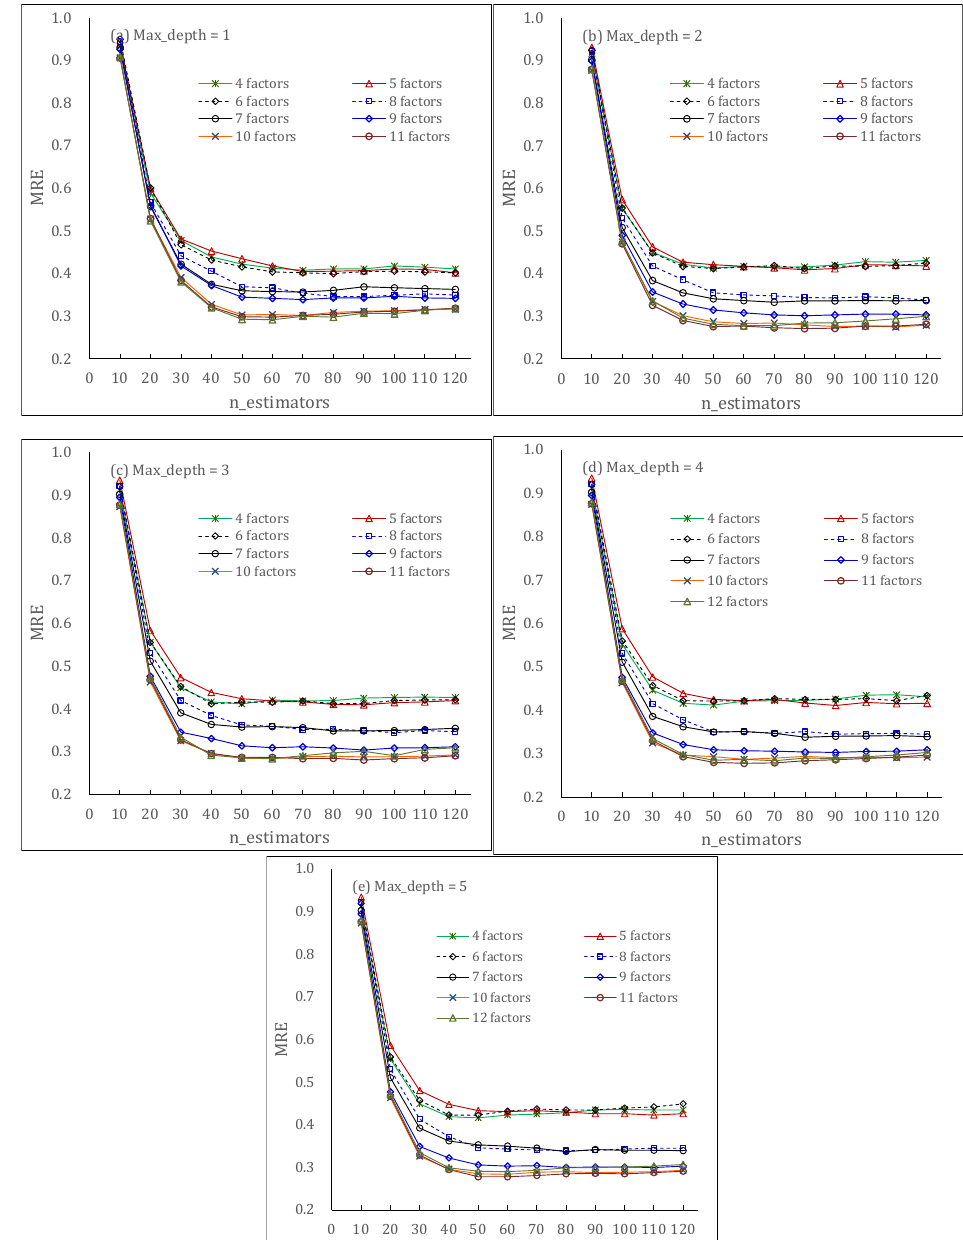
Figure 8. Variation in MRE with different Max_depths and n_estimators. Pane a to e showed the variation in the MRE according to the increasing n_estimator number under different Max_depth values. ( a ) Max_depth = 1, ( b ) Max_depth = 2, ( c ) Max_depth = 3, ( d ) Max_depth = 4, ( e ) Max_depth = 5.